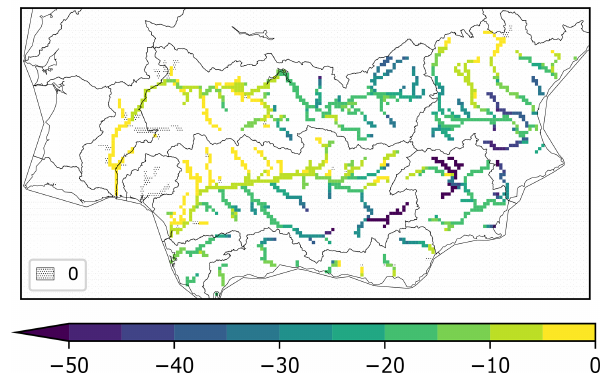
Figure 9. Absolute change in low flow occurrence frequency simu- lated by reducing groundwater irrigation abstraction to sustainable levels, with respect to full irrigation. Reduced frequency indicates improvement. Changes are computed over the 1990–2018 period for grid-cells with upstream areas of at least 500km 2